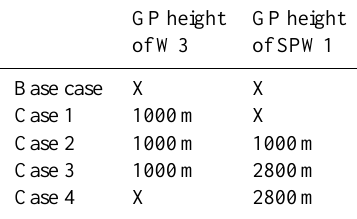
Table 1. The geopotential height perturbations of W3 and SPW1 specified at the lower model boundary for different model